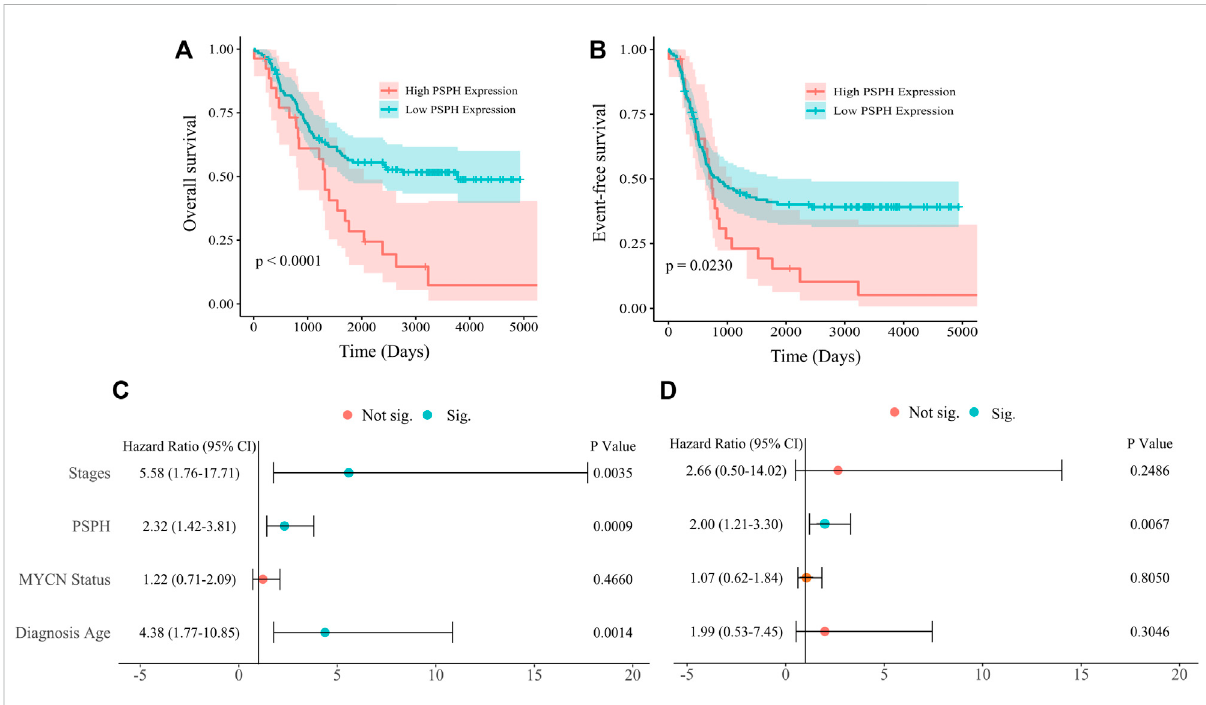
FIGURE 1 Survival analysis of 151 NB patients from the TARGET dataset. (A,B) Showing Kaplan-Meier survival curves of NB patients with different expression of PSPH ( p < 0.0001 for OS; p = 0.0230 for EFS, respectively). (C) Univariate and (D) multivariate Cox analysis indicating that PSPH expressionlevelwasanindependentriskfactorforOSafteradjustedwithotherriskfactorssuchasINSS,MYCNampli fi edstatusandageatdiagnosis. Green dot indicates signi fi